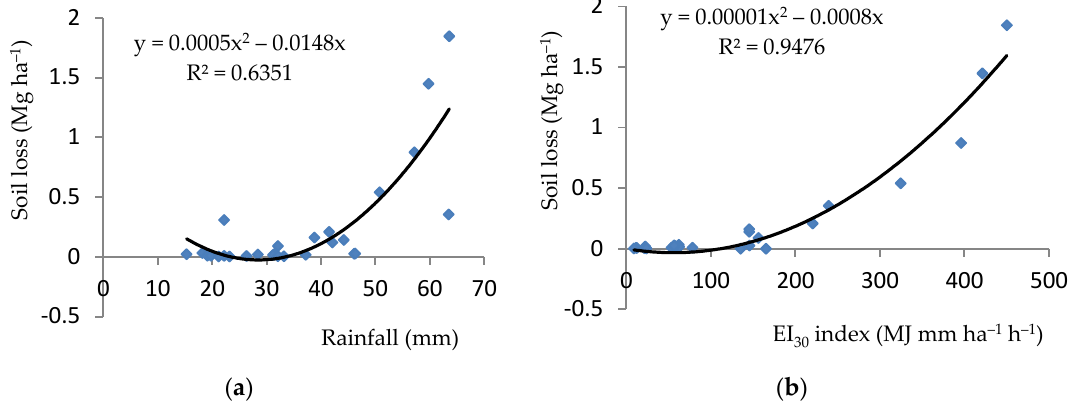
Figure 6. Soil loss in the subsurface runoff per unit area depending on rainfall amount ( a ) and index EI 30 ( b ).